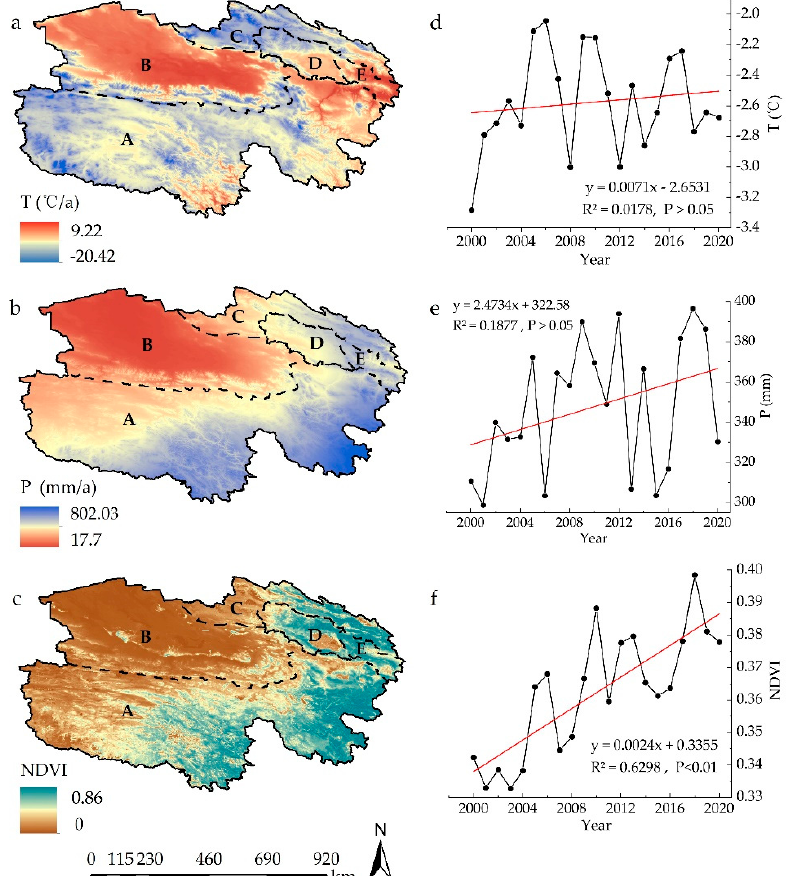
Figure 2. The spatial distribution and temporal changes of annual average T ( a , d ), P ( b , e ), and NDVI ( c , f ) in Qinghai Province during 2000–2020. A–E in the figure represents the Three-River Source region, the Qaidam Basin region, the Qilian Mountain region, the region around Qinghai Lake, and the Hehuang region, respectively.